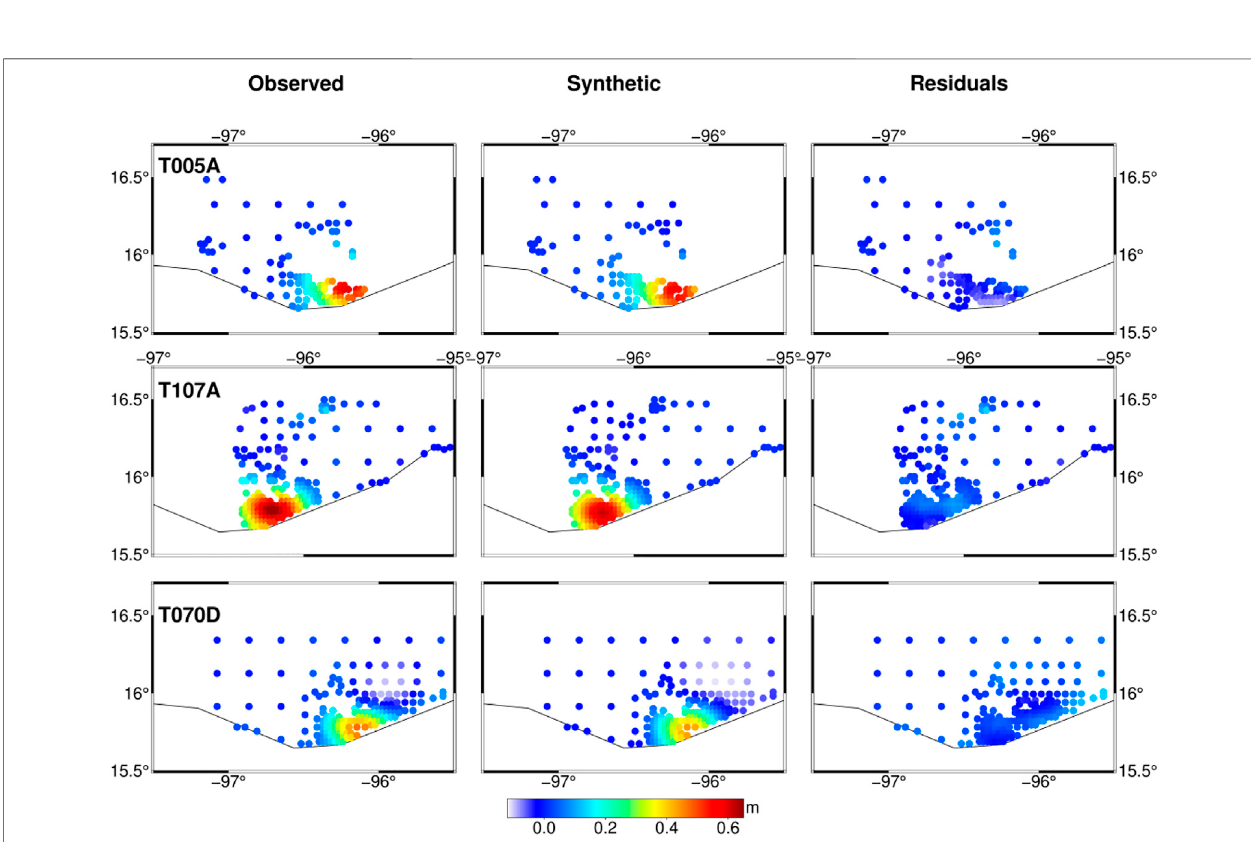
FIGURE 8 | InSAR observed (left panel), synthetic (middle panel), and associated residuals (right panel). The fi rst and second row denotes the T005A and T107A images, respectively, and the third denotes the T070D image.